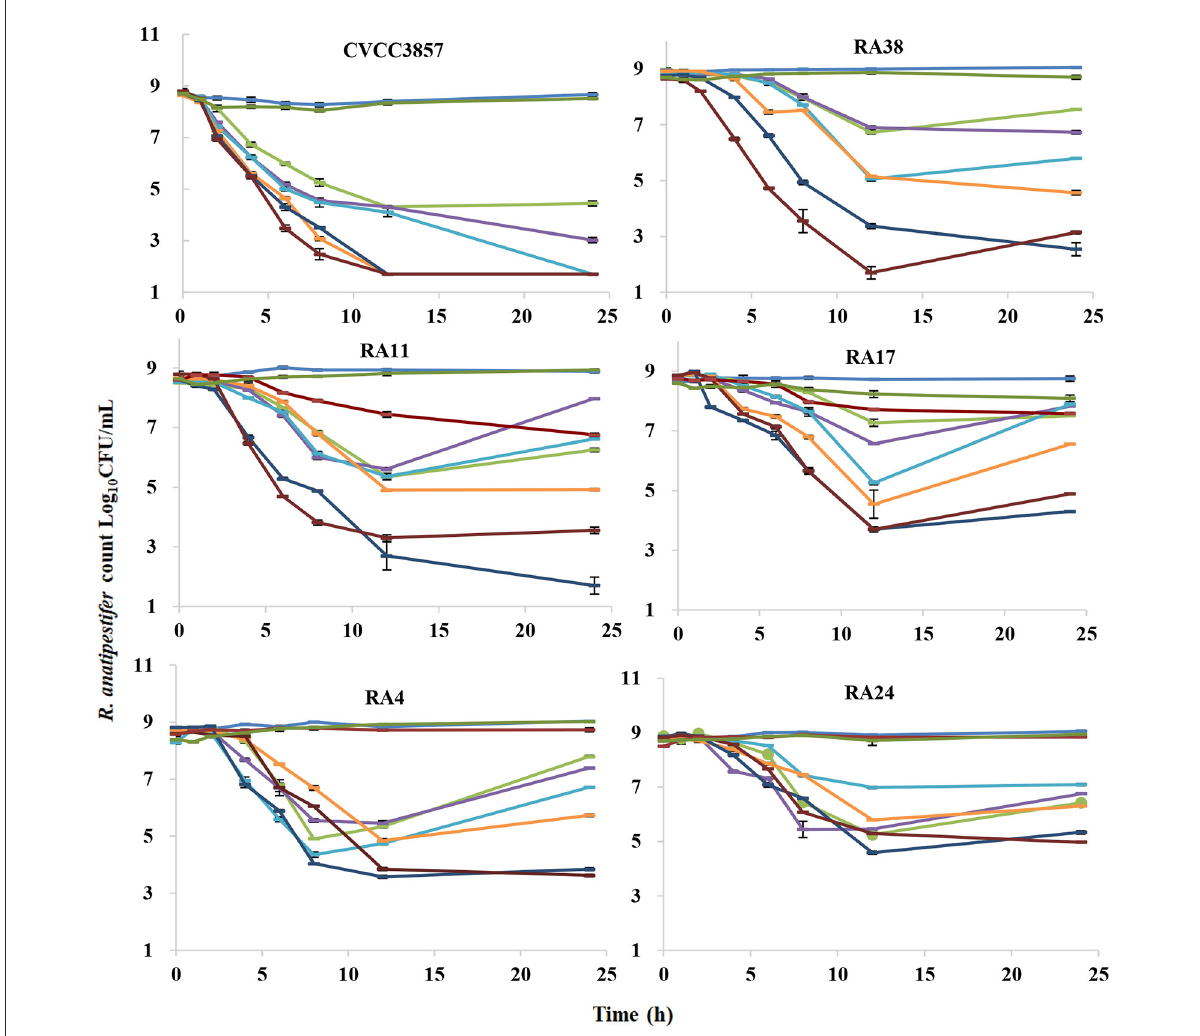
FIGURE6 Dynamic time–kill curves of florfenicol in combination with doxycycline against Riemerella anatipestifer